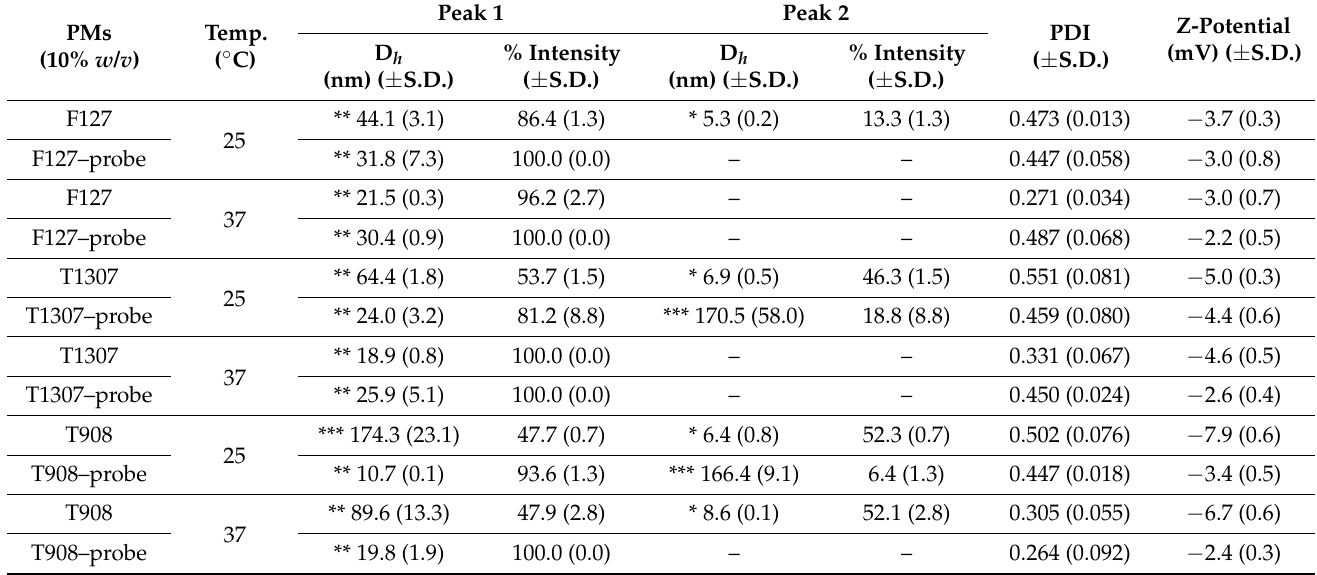
Table 2. Hydrodynamic diameter (D h ), size distribution (PDI), and Z-potential of pristine PMs: F127, T1307, and T908 and PMs-probe: F127-probe, T1307-probe, and T908-probe, as measured by DLS at 25 and 37 ◦ C. The results were expressed as the mean ± S.D. of at least six runs (n = 3). The software used for the analysis of the data was v7.12 software (Malvern